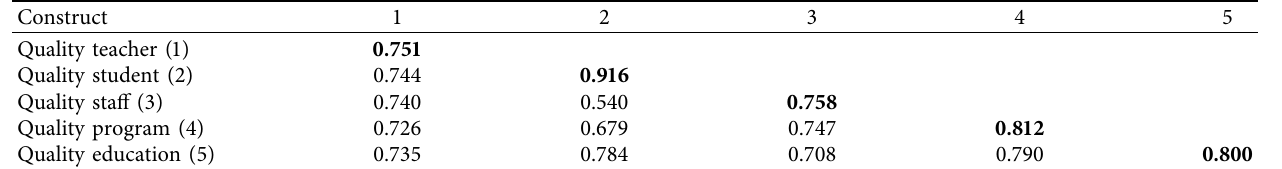
Table 3: Discriminant